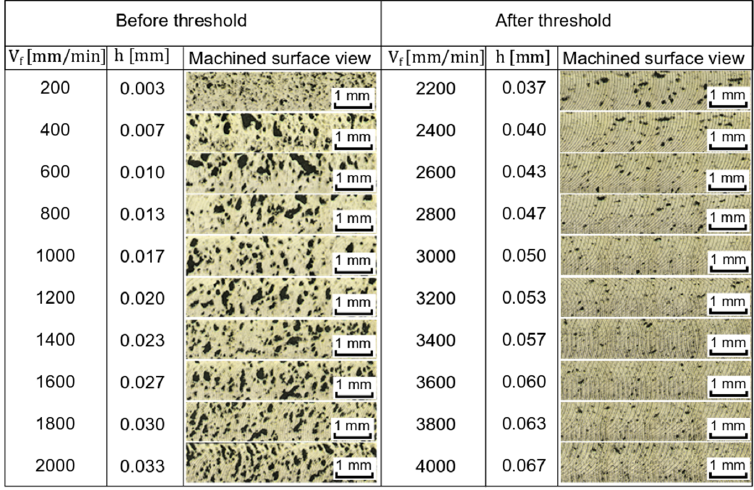
Figure 4. Machining quality at the bottom of the slots .